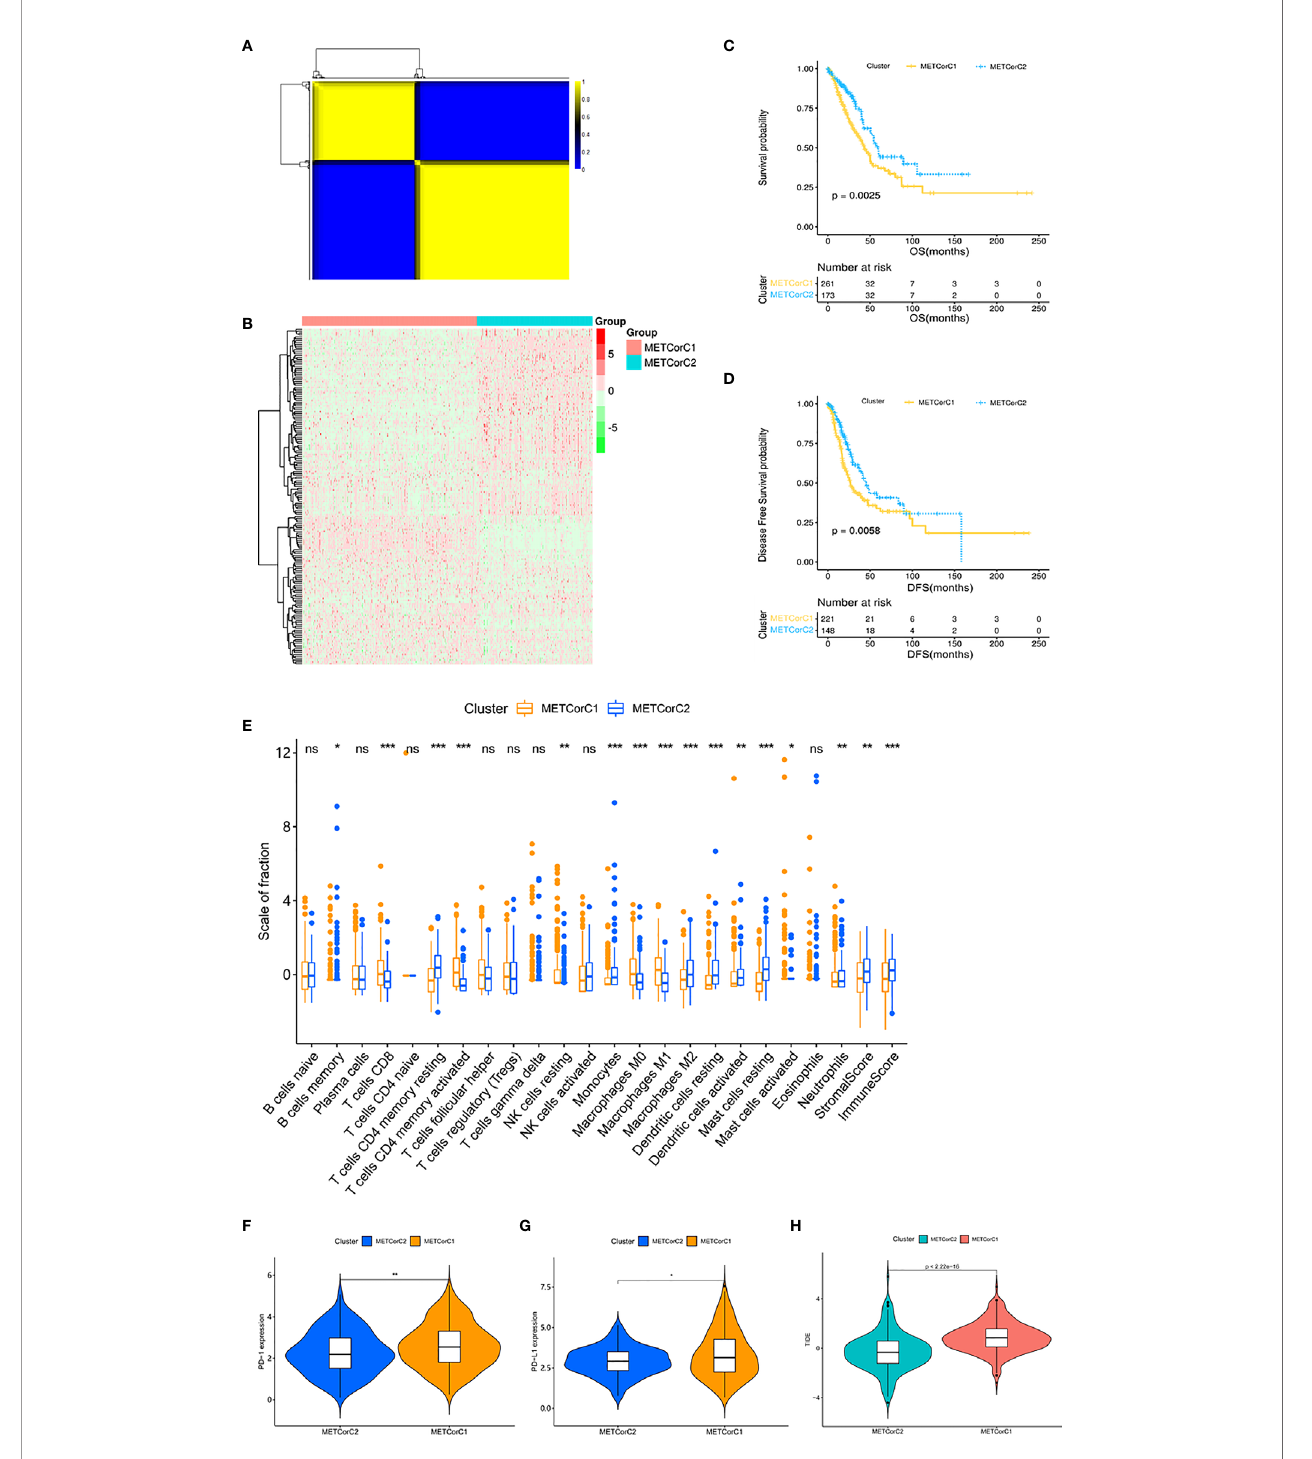
FIGURE 1 | Different outcomes anddifferent patterns of immune cell in fi ltration and immune checkpoints between METcorclusters. (A) The clusteringresults ofNMF. Yellow represents highcorrelation,and the number of yellow squares represents the number ofclusters. (B) Heatmap ofthe beta values related to the METcorgene set. (C) Survival analysis with the Kaplan – Meier curve showed that the OS rate in METCorC1 was signi fi cantly lower than that in METCorC2 (p = 0.0025); (D) the DFS rate in METCorC1 was signi fi cantly lower than that in METCorC2 (p = 0.0058).Signi fi cance was determined using the log-rank p test. (E) The fractionsof22 immune cell types, stromal score, andimmune score inMETCorC1 andMETCorC2. (F, G) Expression level of (F) PD-1 and (G) PD-L1inMETCorclusters. (H) TIDEscore in METcor clusters. *p < 0.05, **p < 0.01, and***p < 0.001. ns, not statistically signi fi